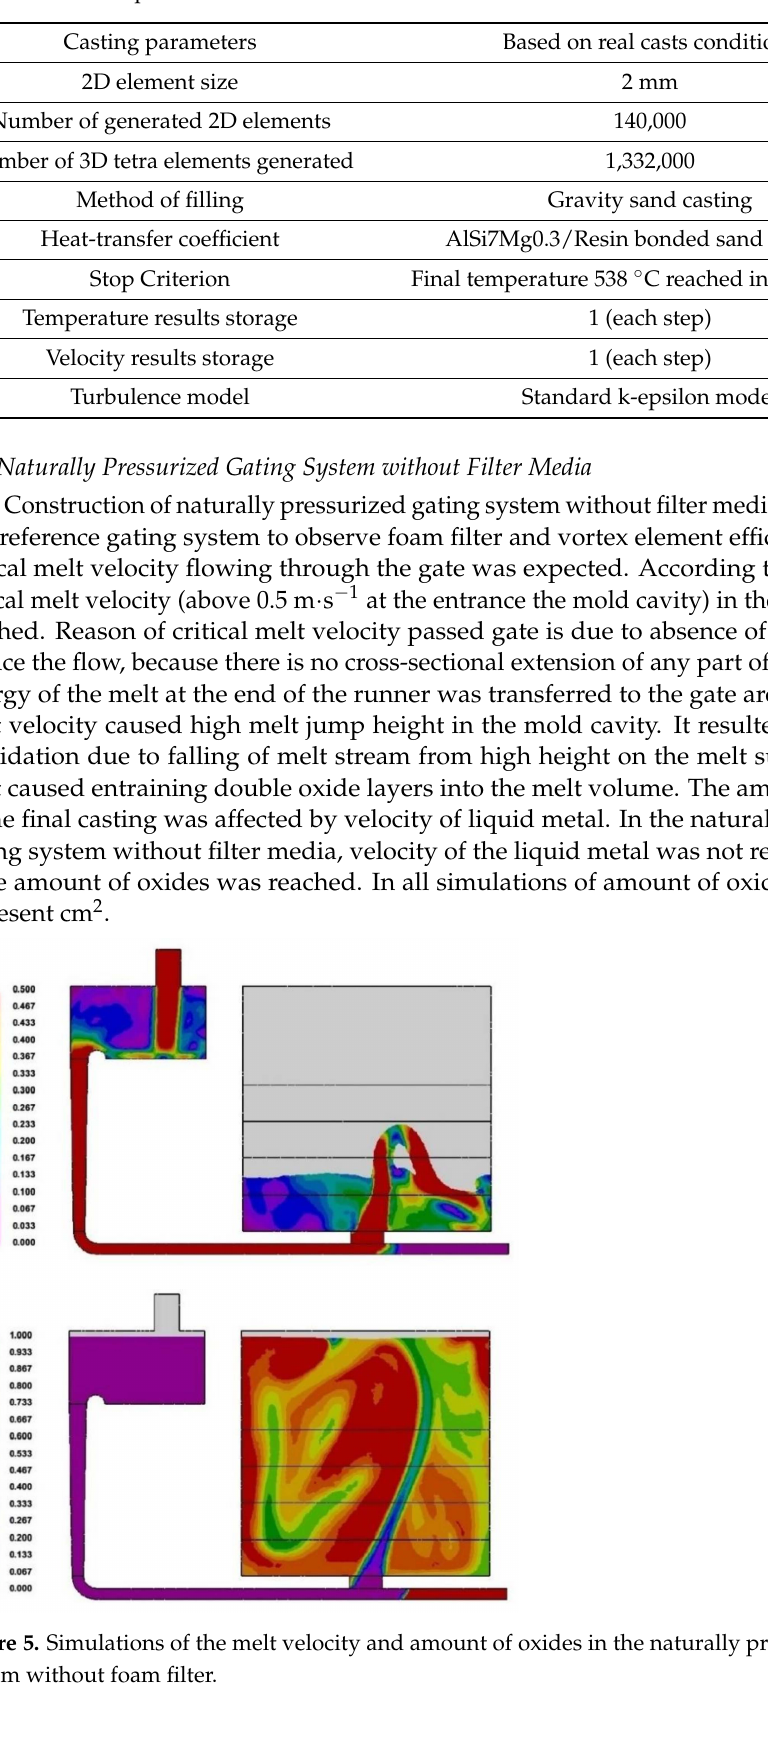
Table 2. ProCAST parameters.